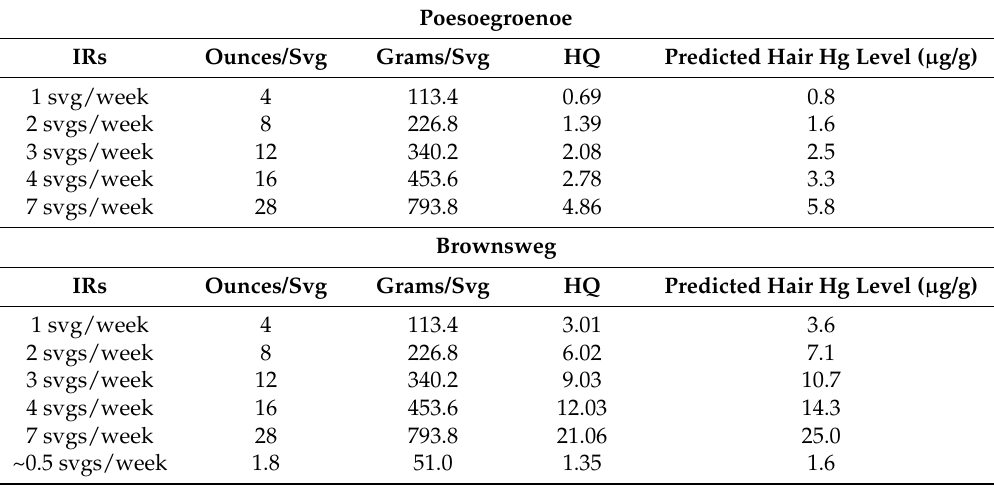
Table 3. Predicted mercury levels in hair of in average individuals from the interior villages of Poesoegroenoe and Brownsweg. Predicted levels of hair mercury were estimated using fish consumption scenarios and plausible intake rates, as well as average mercury levels in freshwater fish collected from streams and rivers in the areas surrounding the villages [36–38]. Modeled scenarios are based on the number of 4 ounce or 114 g servings (svg (s)) consumed per week. Hazard quotients are again provided to demonstrate under which consumption scenarios the intake rates would result in unacceptably high neurodevelopmental health risks. This exercise does support that for the heavy fish consuming village of Poesoegroenoe that a single 4 ounce or 114 g serving per day (7 svgs/week) of locally harvested fish could result in the observed mercury levels in hair. Consistent with the dietary behaviors reported from the village of Brownsweg consuming a much lower amount of locally harvested fish (~0.5 svgs/week or 51.0 g/week) can explain their lower levels of mercury in hair. IRs-intake rates, svg(s)-serving(s).